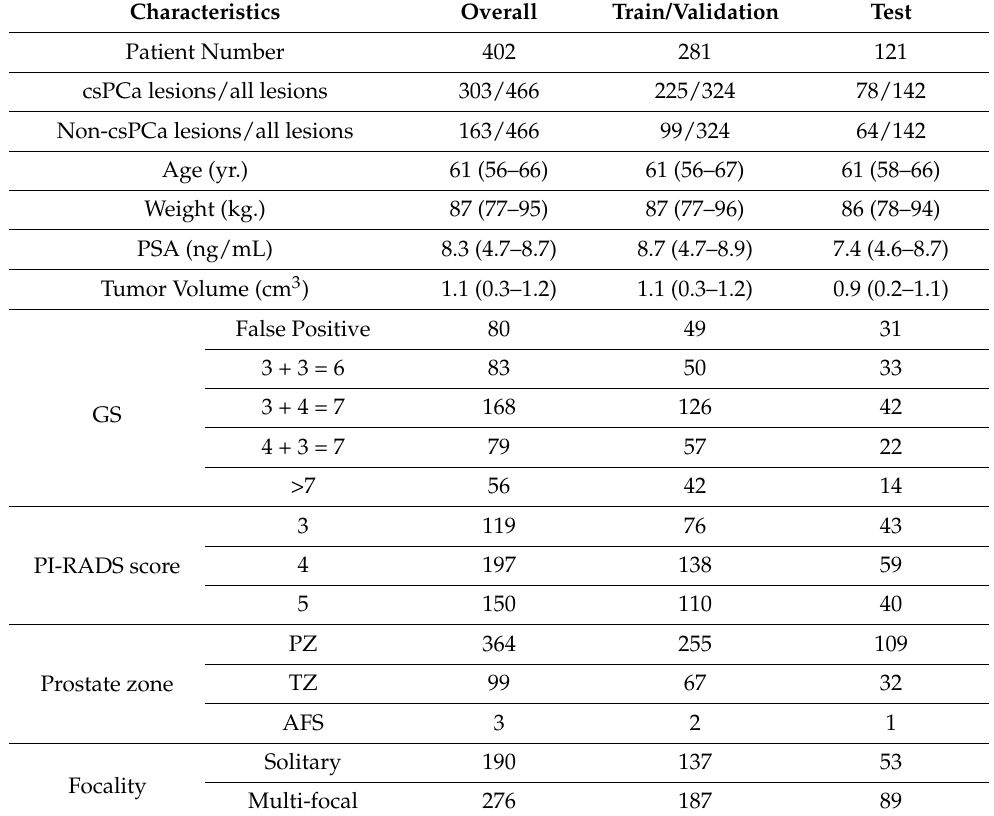
Table 1. Patient and tumor lesion